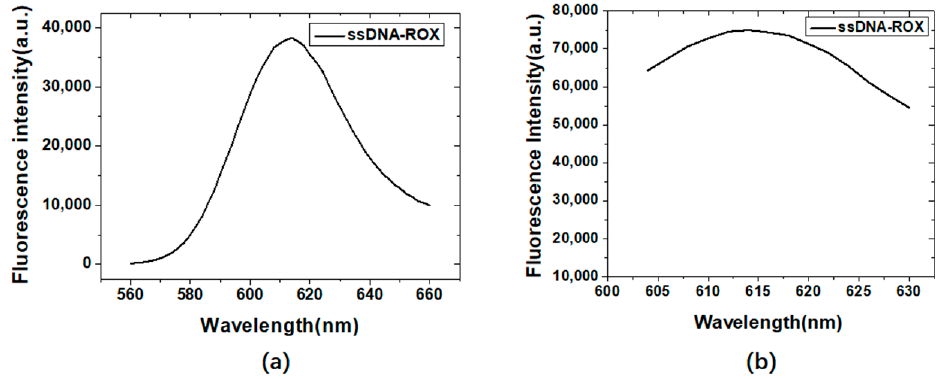
of 500 nm ( a ) and 550 nm ( b ).